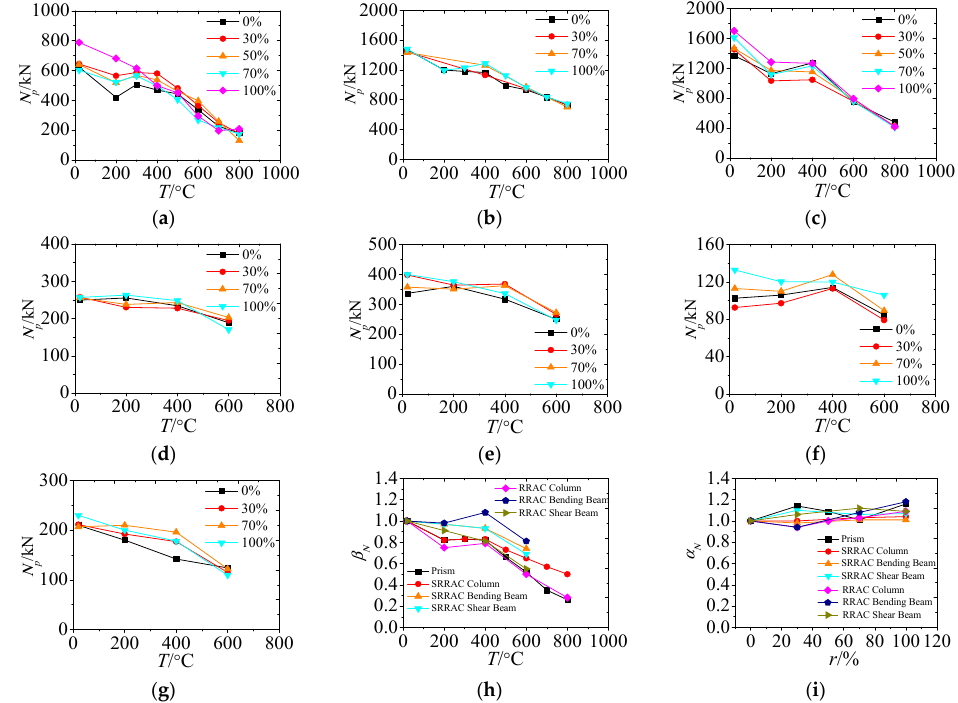
Figure 13. Influence of variation parameters on bearing capacity degradation. ( a ) Prism; ( b ) SRRAC column; ( c ) RRAC column; ( d ) SRRAC bending beam; ( e ) SRRAC shear beam; ( f ) RRAC bending beam; ( g ) RRAC shear beam; ( h ) Temperature; ( i ) Replacement percentage.